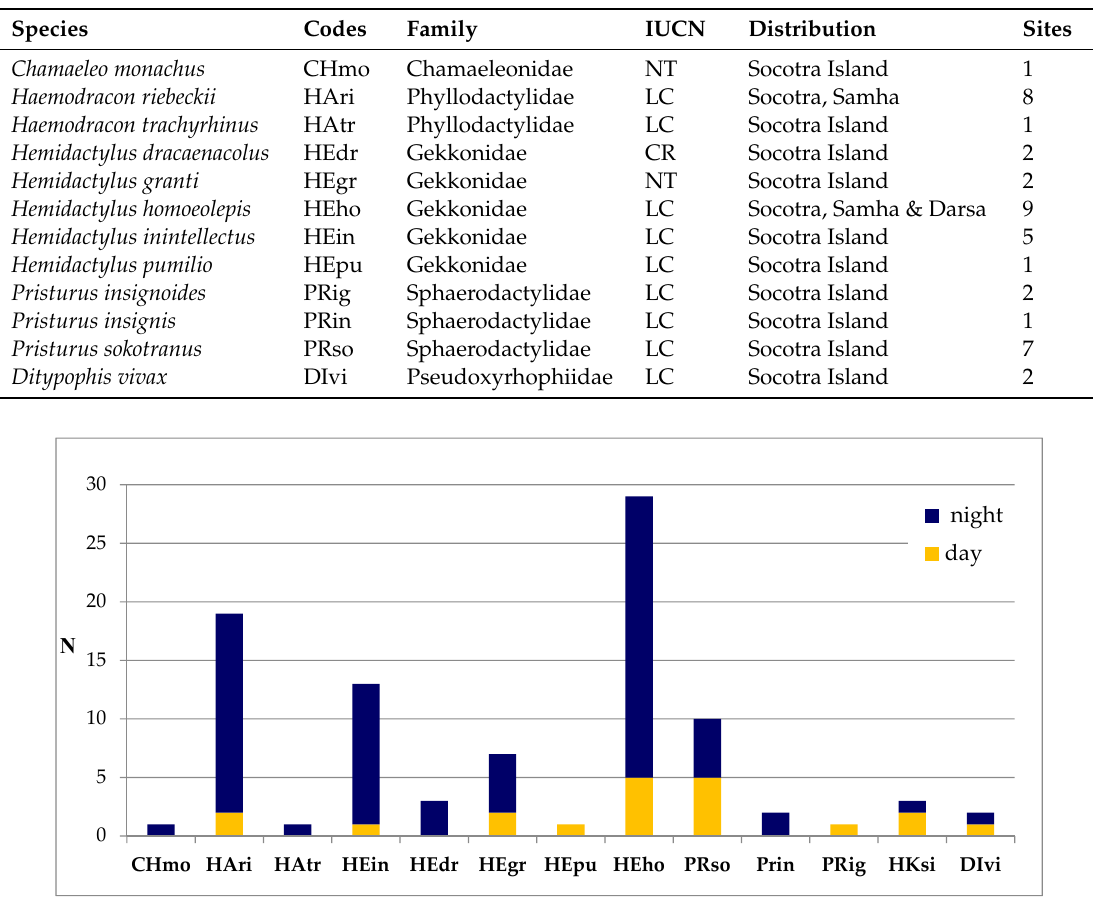
Figure A1. Number of Socotran reptiles found on D. cinnabari trees. Colors indicate when animals were found (blue: at night; yellow: at daytime). The codes of species are shown in Table